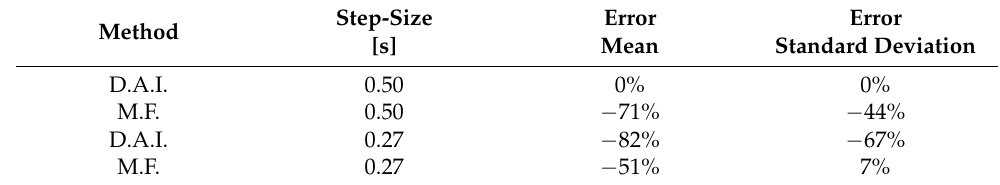
Table 4. Percent performance improvement for D.A.I. and model-following adaptive control.